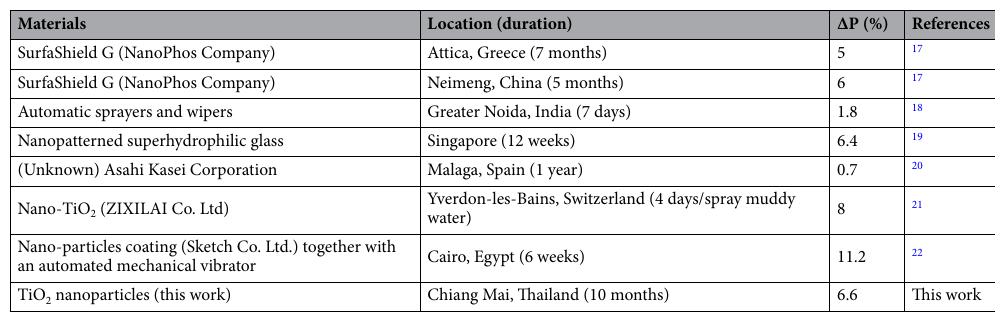
Table 1. Comparison of average power difference (ΔP) of the coated and uncoated solar panels in real